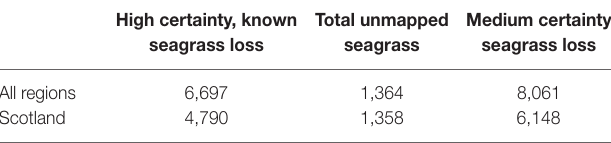
TABLE 4 | Estimated seagrass loss from high (known) and medium (unmapped) estimates across all regions and Scotland, calculated by analysing data older than 1998 from the OSPAR